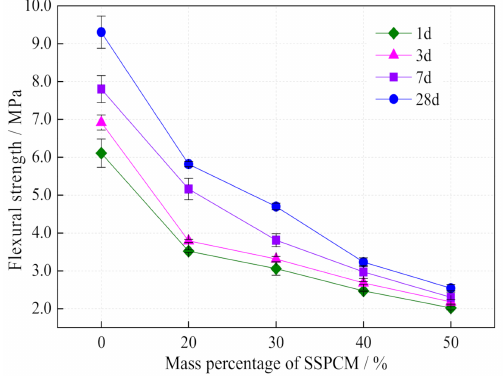
Figure 17. Flexural strength of SCTESM.